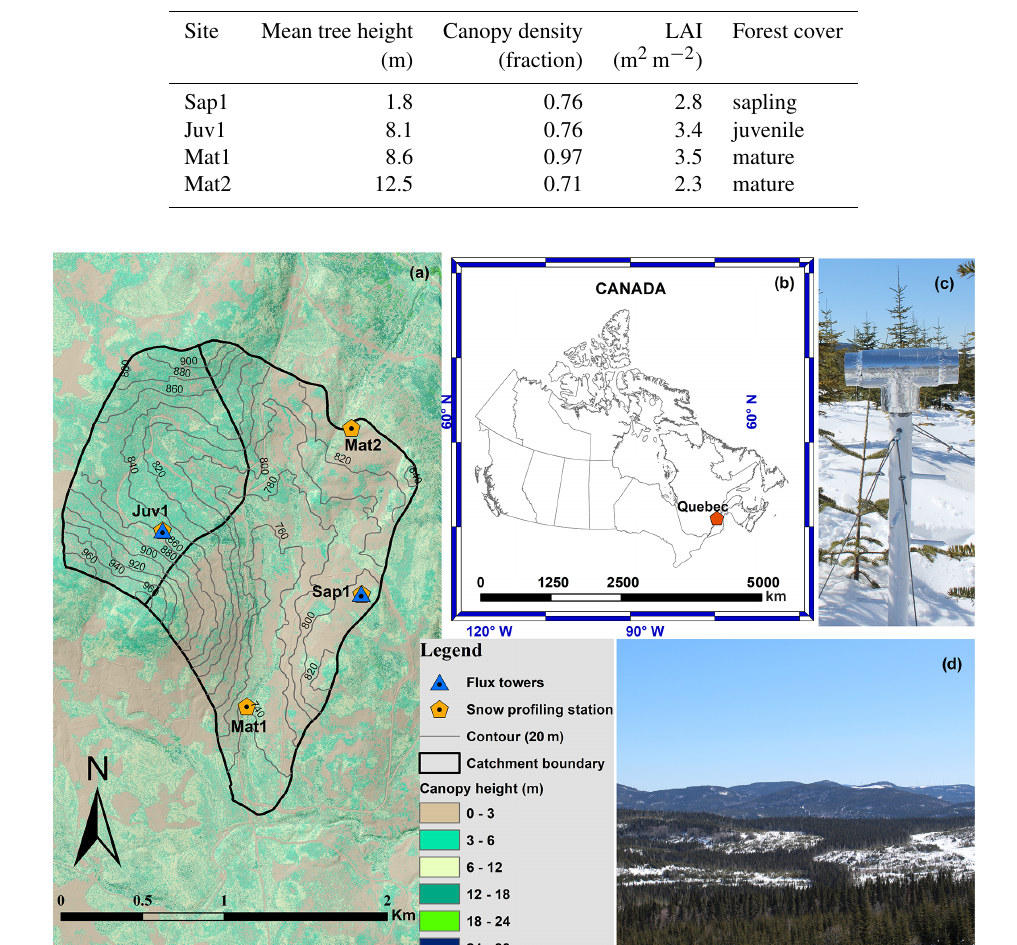
Table 1. General canopy characteristics at the four experimental sites. “Sap” stands for sapling, “Juv” for juvenile, and “Mat” for mature.